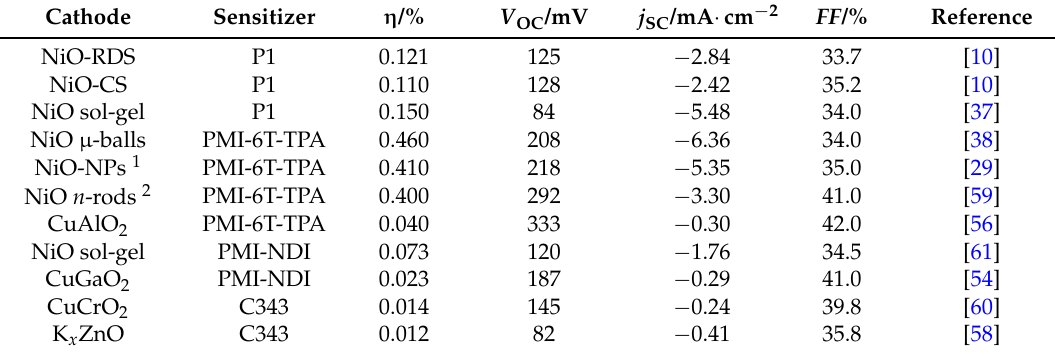
Figure 10. Potential energy diagram comparing the relative positions of the upper edge of the VB for NiO and CuGaO 2 photocathodes sensitized with the same sensitizer (not specified). Upon adoption of the same redox mediator the amplitude of the open circuit voltage V OC increases in passing from NiO to CuGaO 2 . Adapted from reference [53]. Table 1. Characteristic parameters of the p -DSCs differing for the nature of the nanostructured photocathode and dye-sensitizer. Redox shuttle: I 3 ´ /I ´ in acetonitrile.